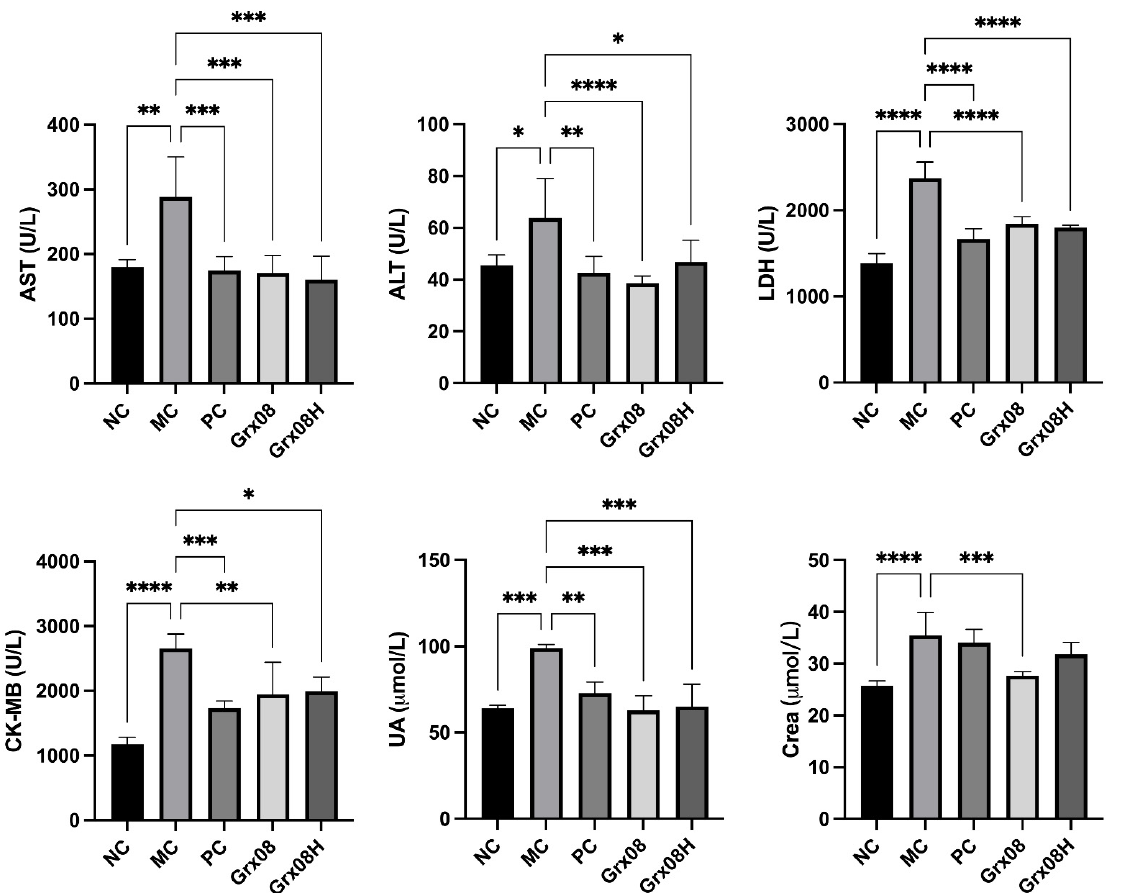
Figure 1. Effect of probiotics on serum biochemical indices of rats ( n = 5). * indicates a significant difference between groups ( p < 0.05), ** indicates a significant difference between groups (p < 0.01), *** indicates a significant difference between groups ( p < 0.001), **** indicates a significant difference between groups ( p < 0.0001), same as below.